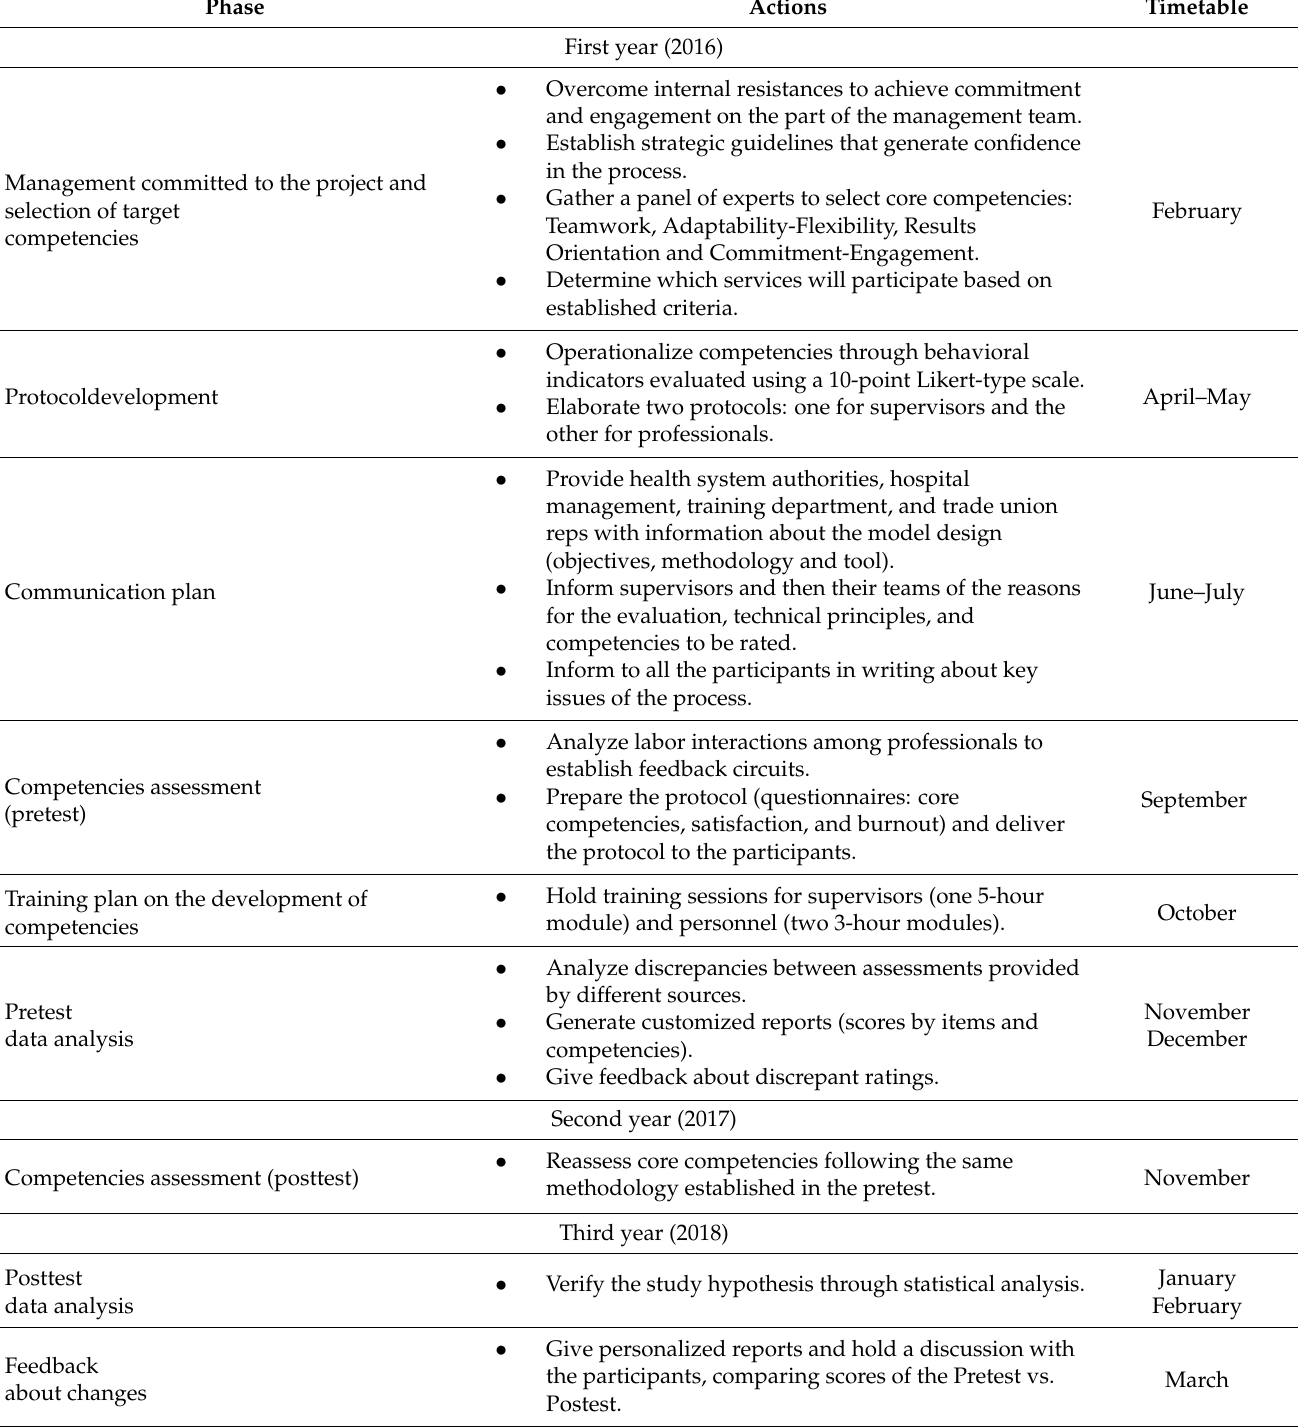
Table 1. Phases and planned actions of the training intervention program and 360 ◦ MSF